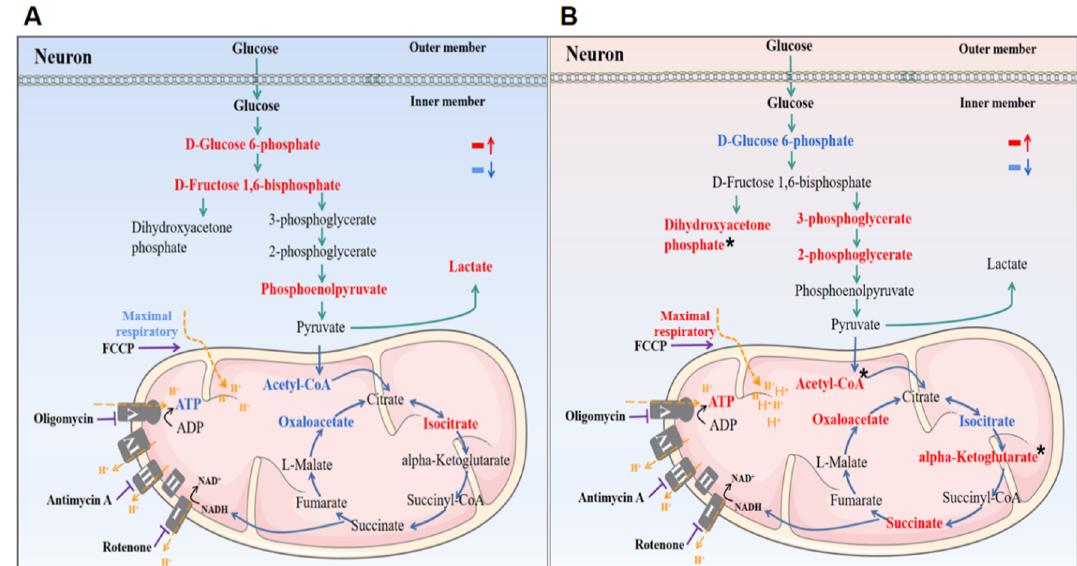
Figure 6. Gas and HBA attenuate H 2 O 2 -induced mitochondrial dysfunction in HT-22 cells. ( A ) The mitochondrial respiratory efficiency of cells treated with 37.5 and 50 μ M Gas and HBA and 500 μ M H 2 O 2 was determined with a Seahorse XF96 analyzer; ( B ) Basal respiration quantification analysis; ( C ) Maximal respiration quantitative analysis; ( D ) ATP production quantitative analysis. Data are